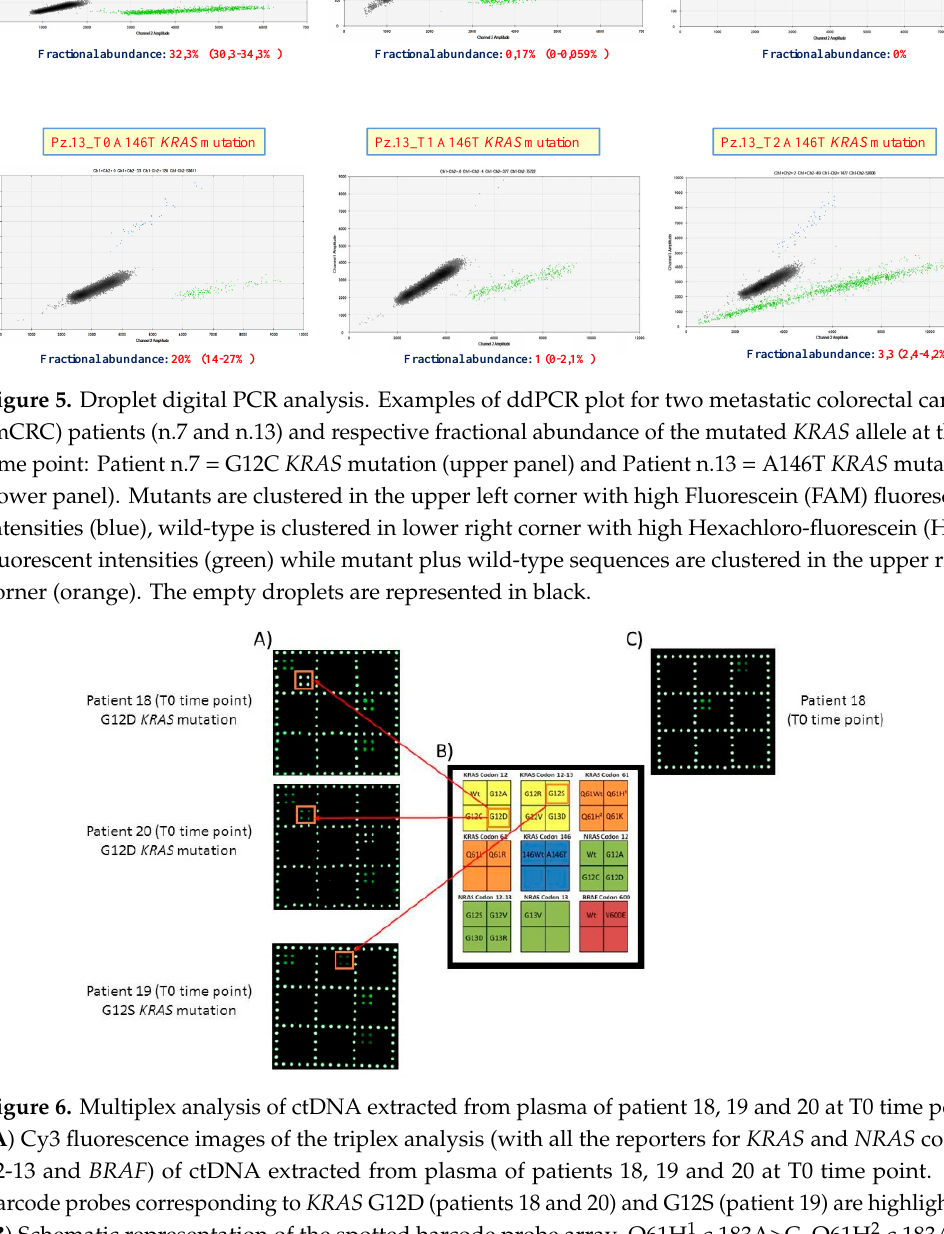
Figure 6. Multiplex analysis of ctDNA extracted from plasma of patient 18, 19 and 20 at T0 time point. ( A ) Cy3 fluorescence images of the triplex analysis (with all the reporters for KRAS and NRAS codon 12-13 and BRAF ) of ctDNA extracted from plasma of patients 18, 19 and 20 at T0 time point. The barcode probes corresponding to KRAS G12D (patients 18 and 20) and G12S (patient 19) are highlighted. ( B ) Schematic representation of the spotted barcode probe array. Q61H 1 c.183A > C, Q61H 2 c.183A > T. ( C ) Cy3 fluorescence image of the duplex analysis (with all the reporters for KRAS codon 61 and 146) of ctDNA extracted from plasma of patient 18 at T0 time-point. Only the barcode probes corresponding to KRAS codon 61 and 146 wild-type sequences are shown.